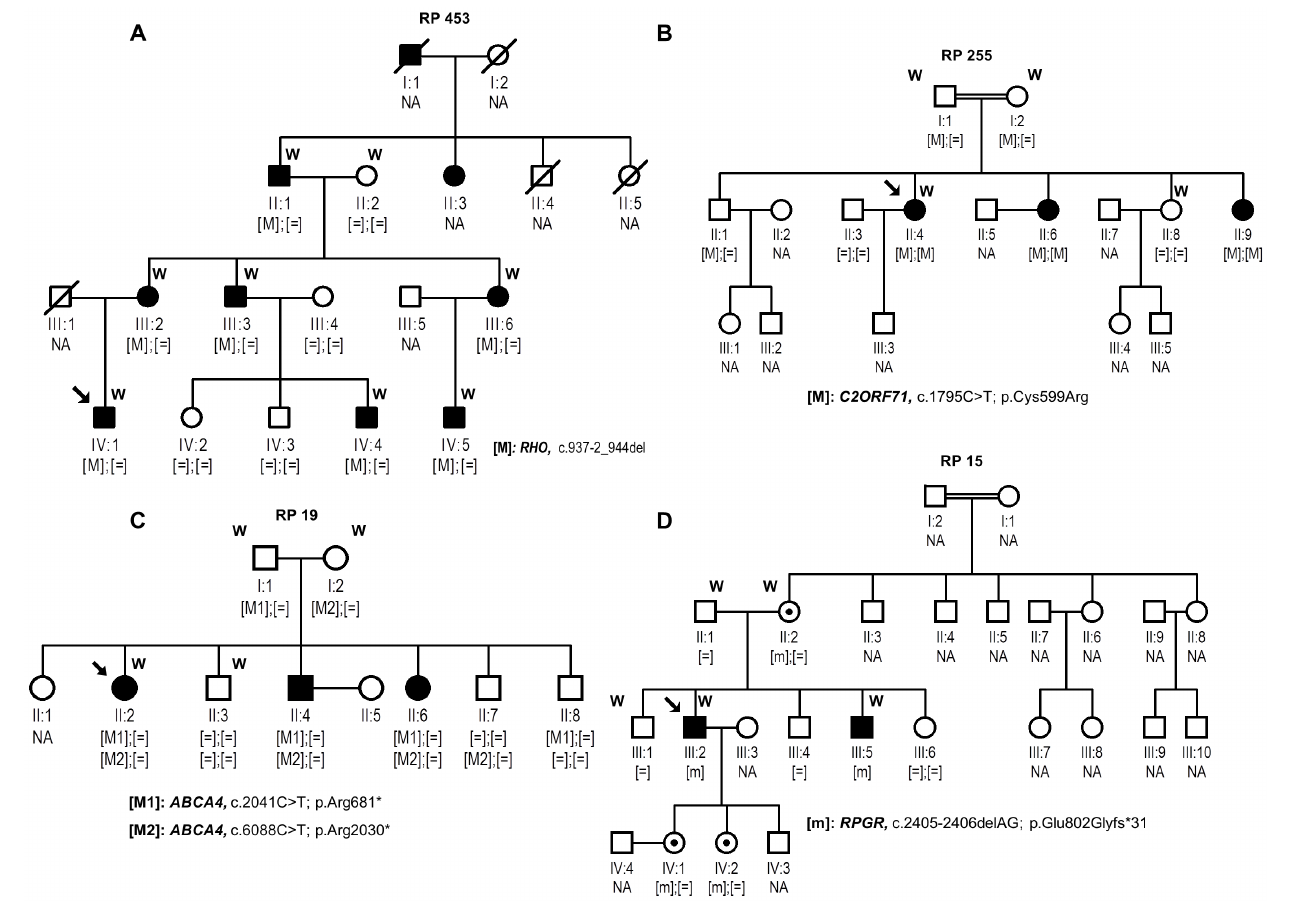
Fig. 1. Segregation studies of identified variants in the four analyzed families. Below the individuals, genotypes are presented for each change segregating with RP. Index patients are indicated with a black arrow. [M];[M] represents homozygous mutants; [M];[ 5 ] indicates heterozygous carriers, [ 5 ];[ 5 ] indicates individuals carrying two wild-type alleles, whereas [m] represents hemizygous individuals. NA means non available DNA sample. W means samples processed by